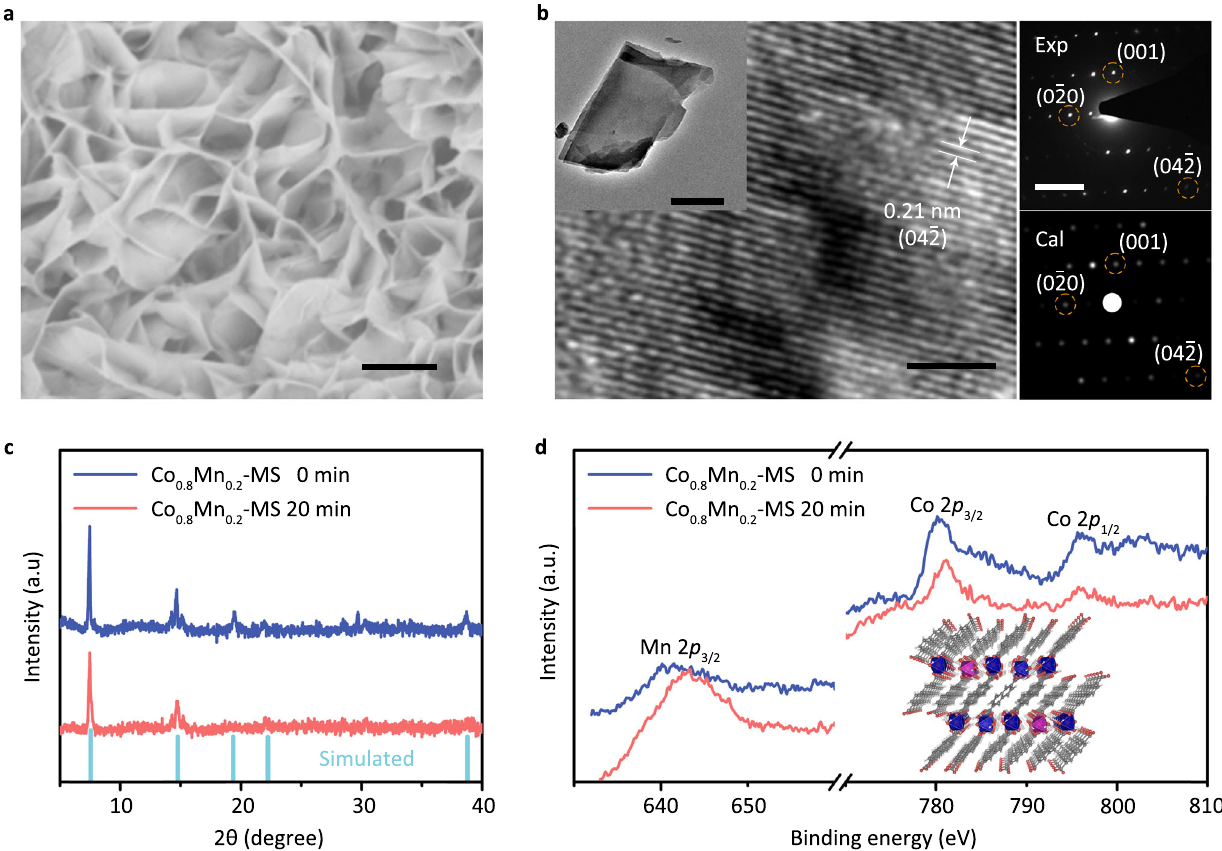
Fig. 2 Physical characterization. a FE-SEM image of Co 0.8 Mn 0.2 -MOF grown on NF (Scale bar, 5 μ m). b HR-TEM image of Co 0.8 Mn 0.2 -MOF in the left panel (Scale bar, 2 nm) and the experimental (top) and simulated (bottom) SAED pattern in the right panel (Scale bar, 2/nm). Inset: the TEM image (Scale bar, 1 μ m). c XRD patterns and d XPS high-resolution spectra of Co 0.8 Mn 0.2 -MOF samples with and without